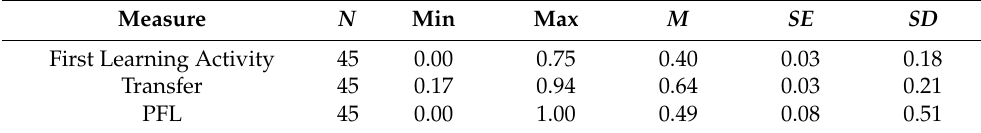
Table 6. Descriptive statistics for each learning measure.